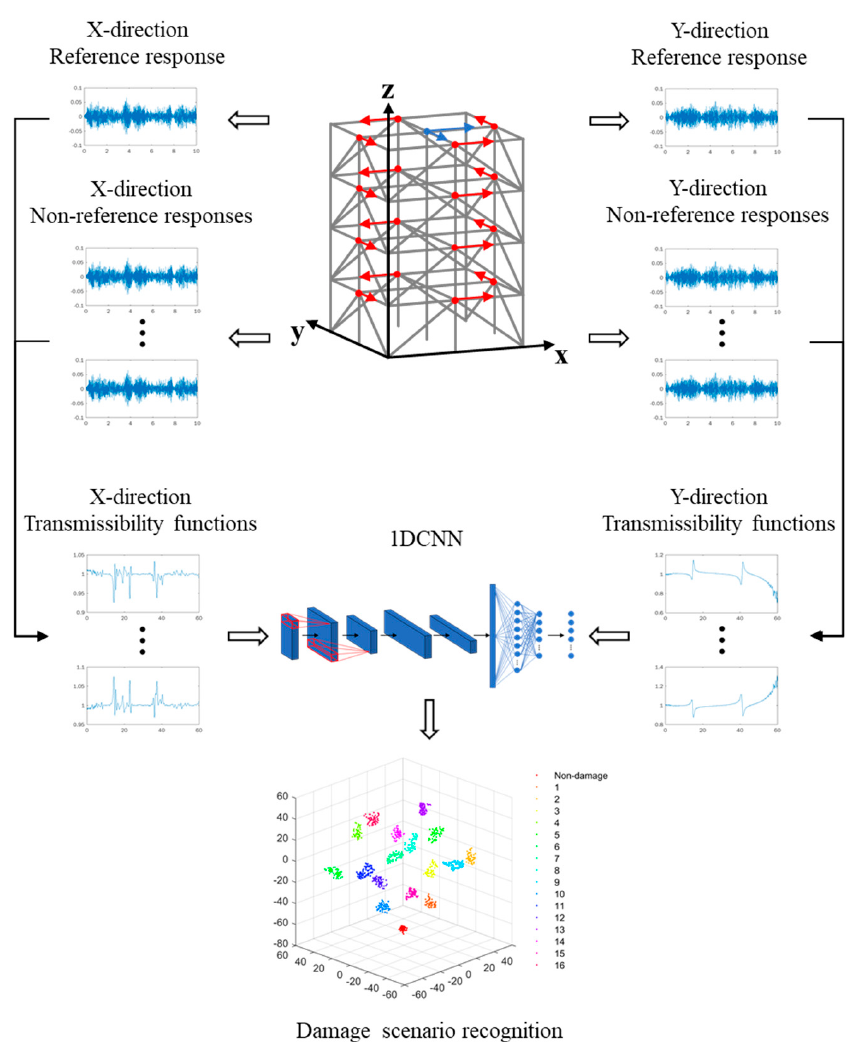
Figure 2. Illustration of transmissibility function (TF)-1D CNN damage identification framework.